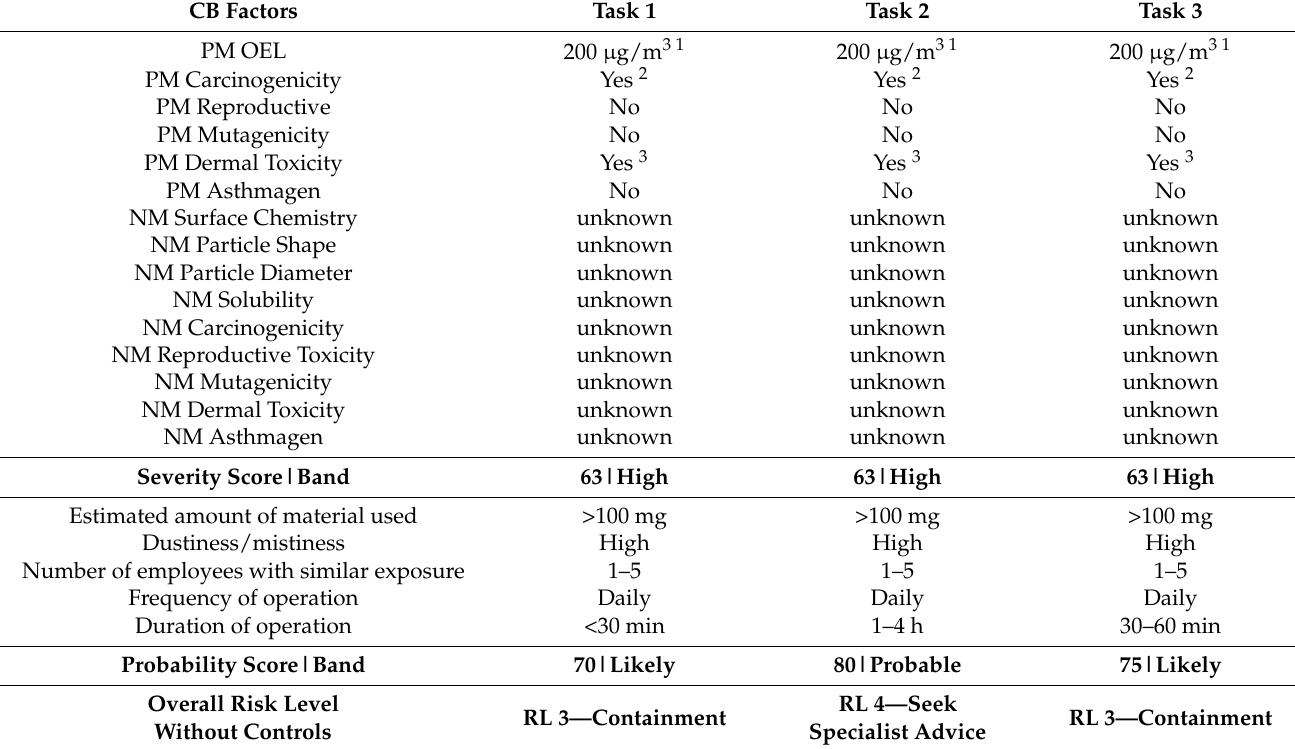
Table 5. Results of the application of CB Nanotool version 2.0 for the conditions of Trial